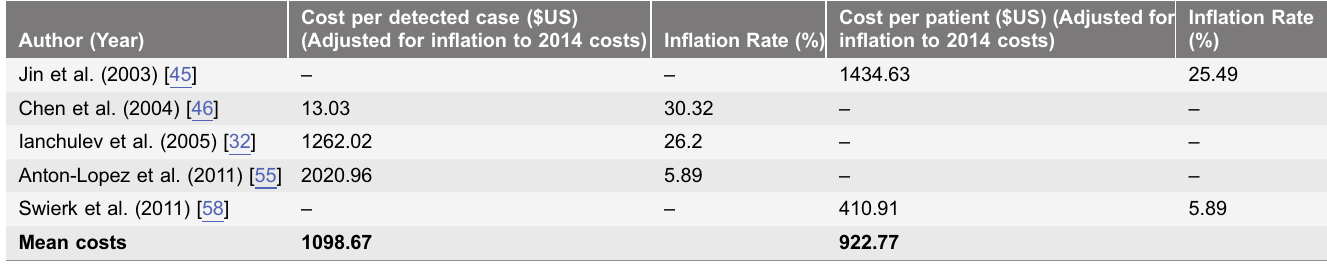
Table 7. Teleglaucoma estimated 2014 unit